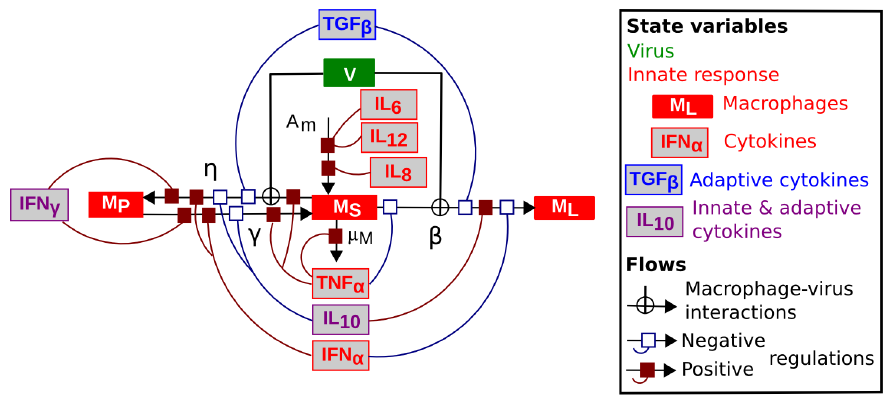
Figure 3. Susceptible macrophage dynamics with cytokine regulations. The state variables represented are: the free viral particles ( V ); the susceptible ( M S ), phagocyting ( M P ) and latent ( M L ) macrophages; the pro-inflammatory cytokines ( IL 6 & IL 8 ), the innate antiviral cytokines ( IFN a & TNF a ) and the immuno-regulatory cytokines ( IL 12 , IFN c , IL 10 & TGF b ). All processes that impact the susceptible macrophages are included: recruitment ( A m ), decay ( m M , simplified notation), phagocytosis ( g and c ) and infection ( b ); their positive and negative regulations by cytokines are also drawn.